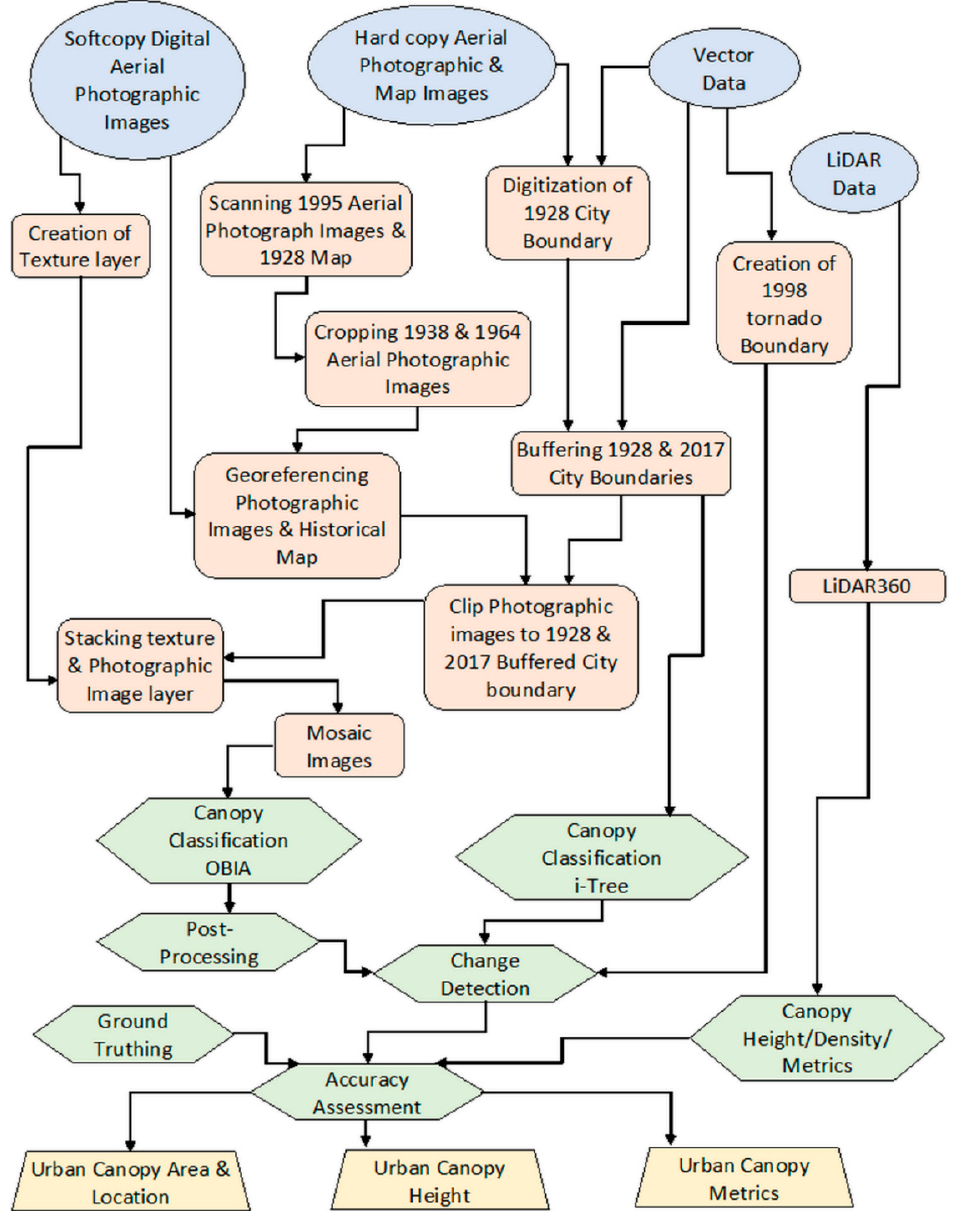
Figure 2. Methodology Schematic.